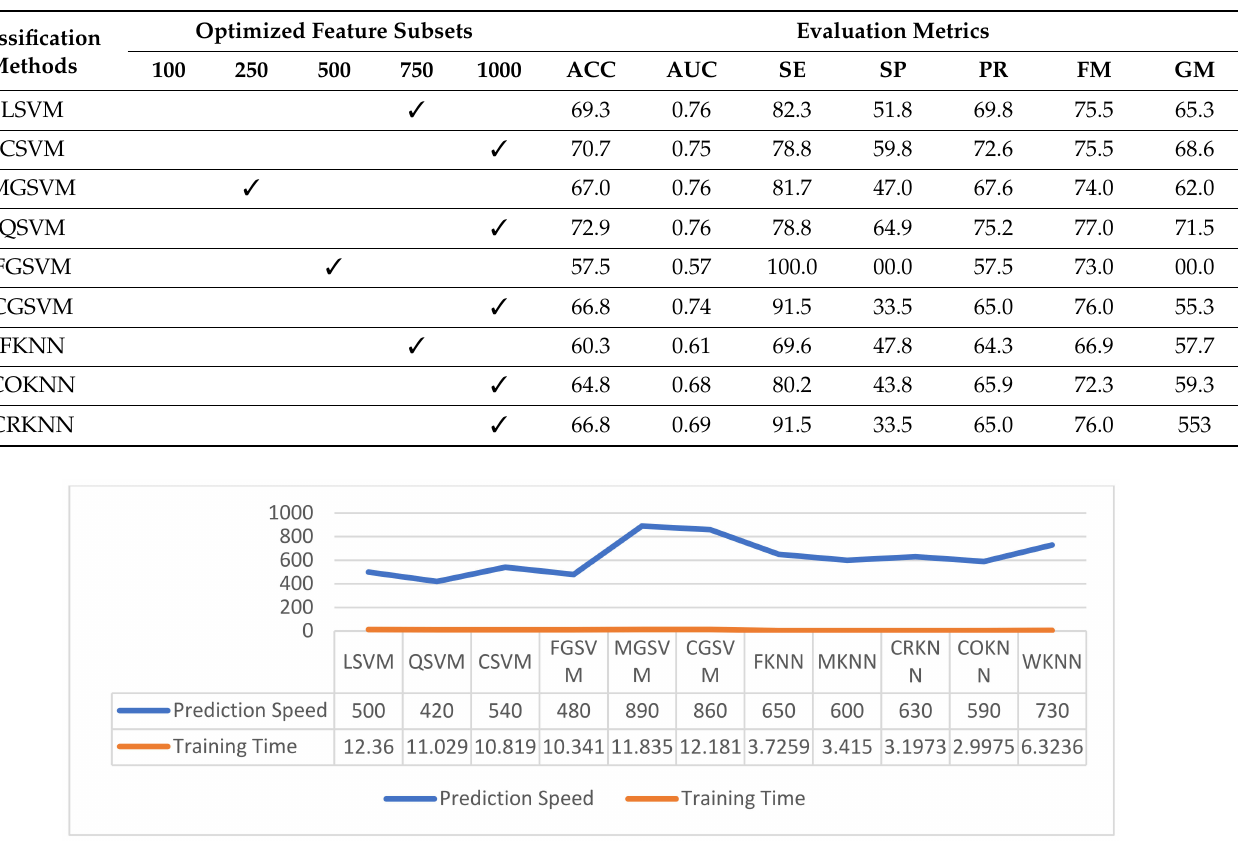
Table 9. Front view-based experimental results on VIPeR dataset.